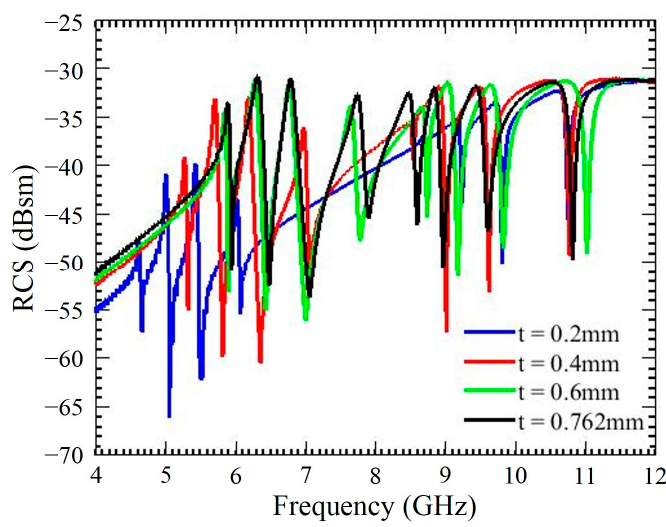
Figure 12. Effect of substrate thickness on RCS response of tag.